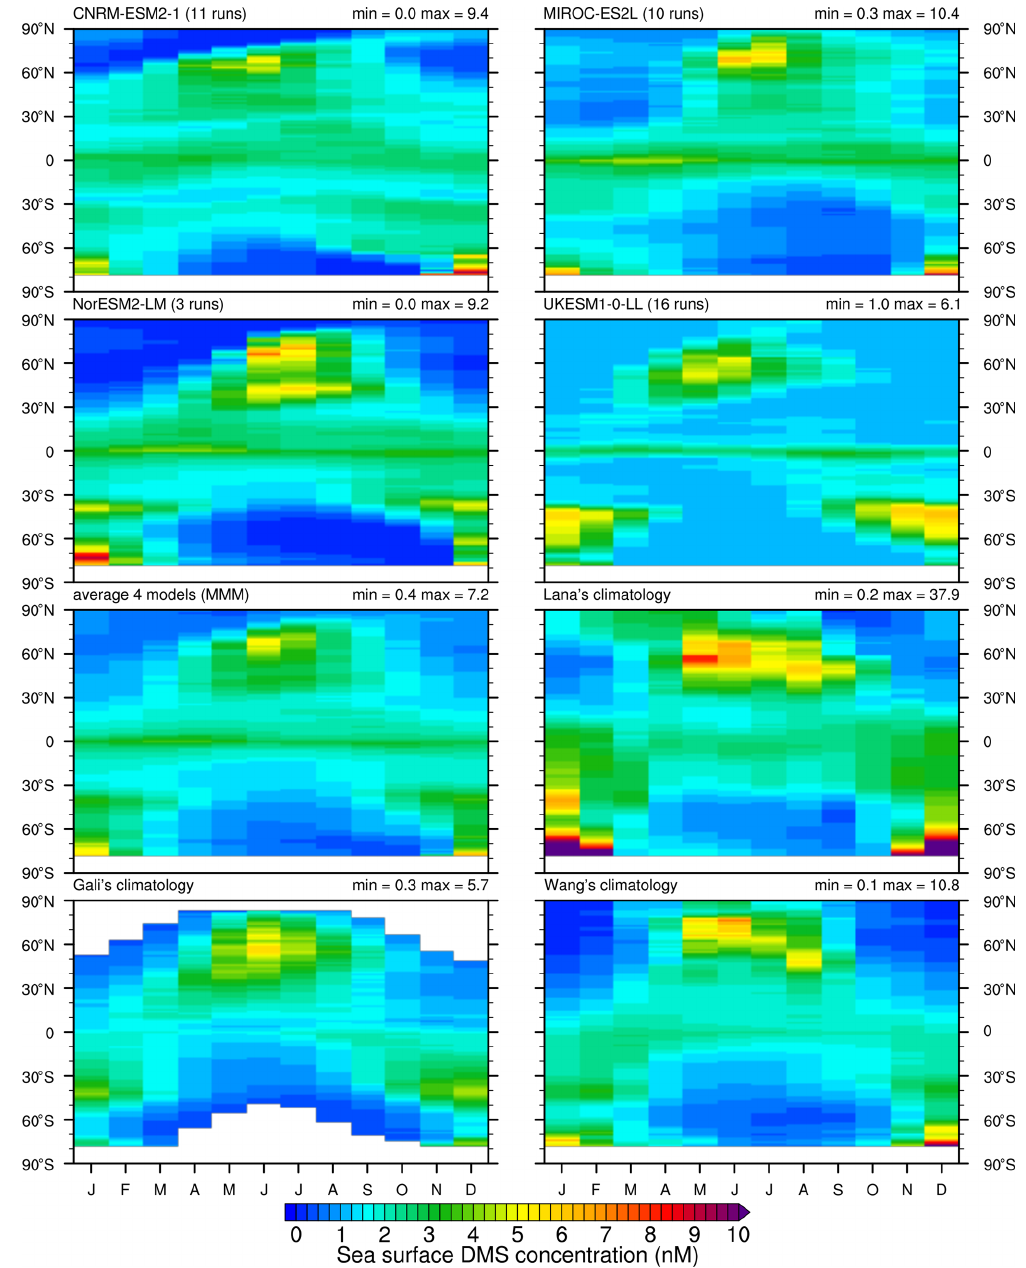
Figure 3. Monthly mean (1980–2009) zonal surface ocean DMS concentration (nM) for the same models and observations as in Fig.